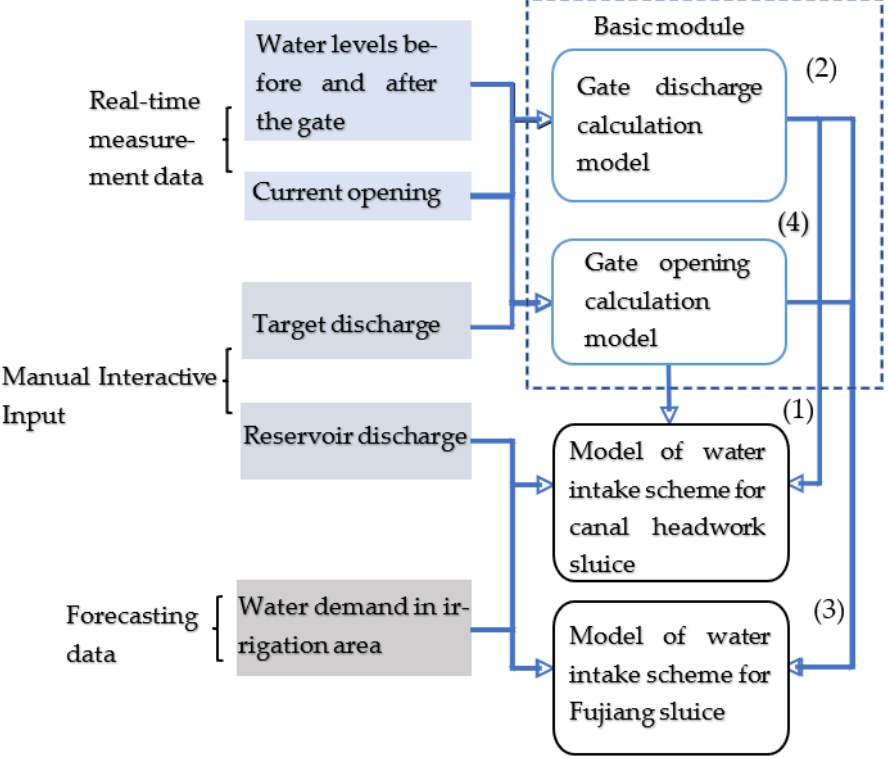
Figure 5. Design of the plug-in module division of the basic water distribution scheduling model of the intake complex.